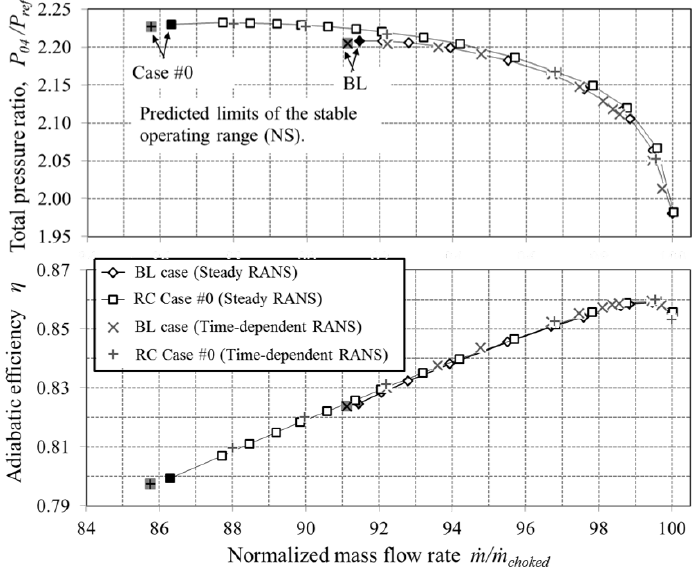
Figure 13. Comparison of overall compressor performance characteristics between steady Reynolds Averaged Navier Stokes (RANS) simulations and time-dependent RANS simulations.